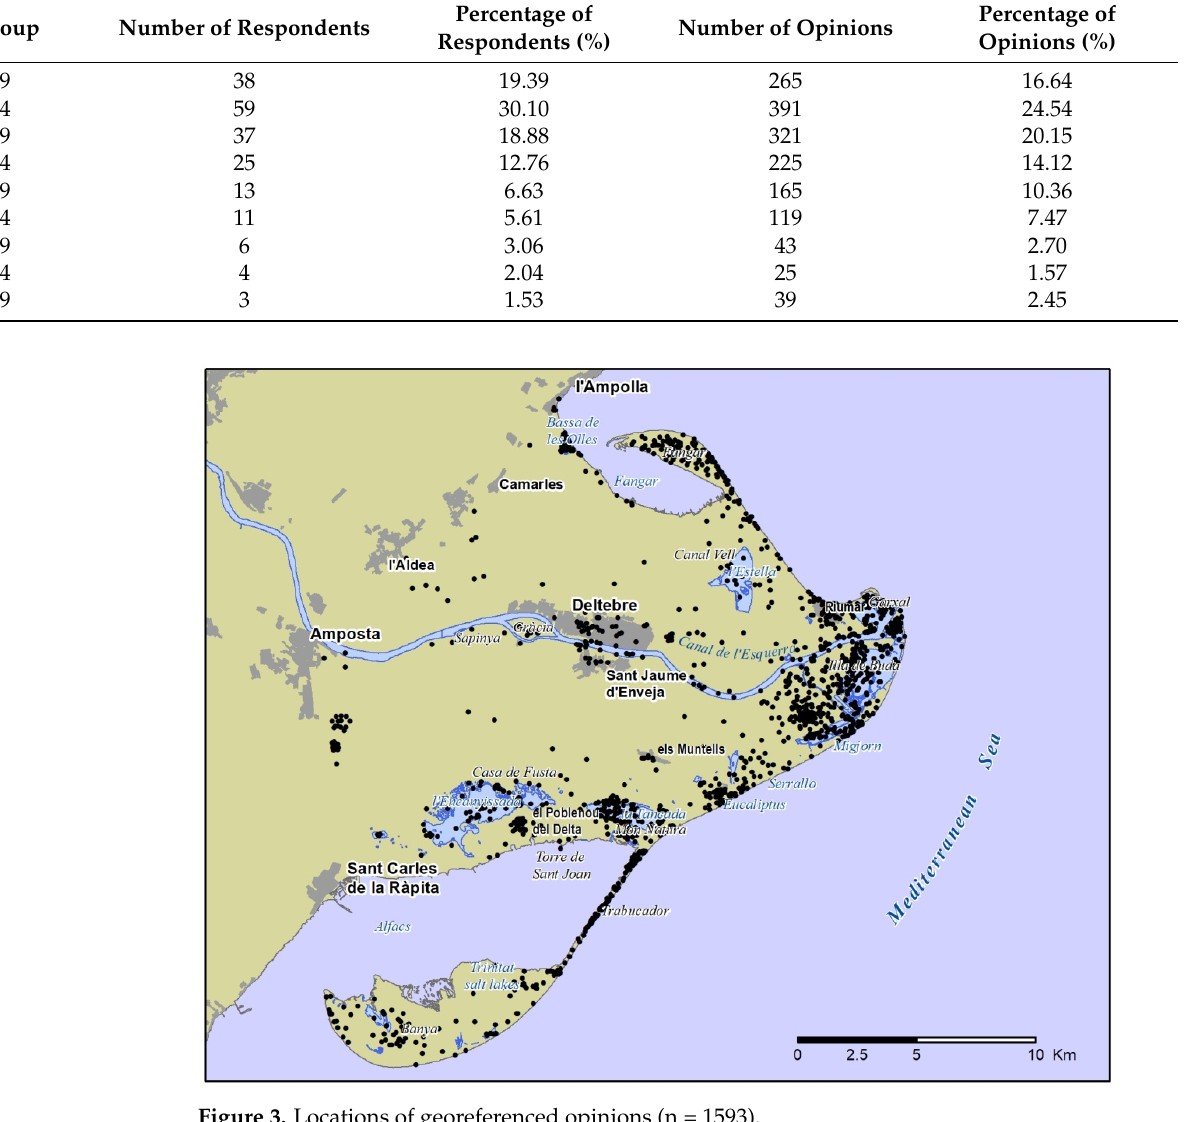
Figure 3. Locations of georeferenced opinions (n = 1593).